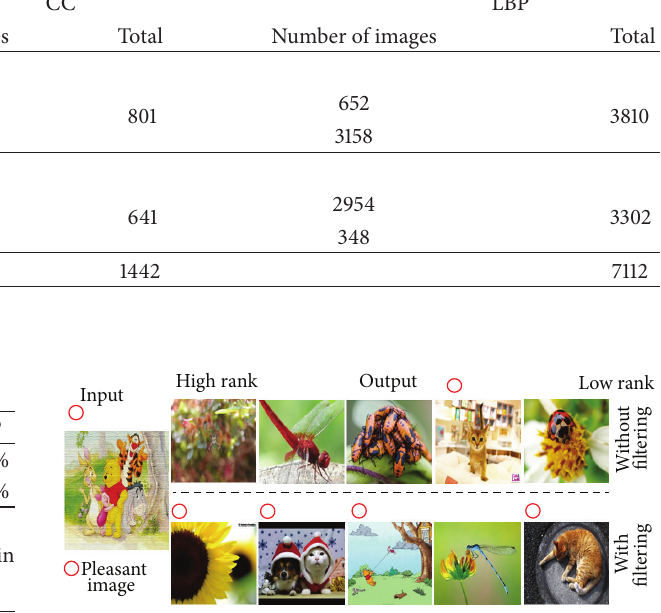
Figure 4: Improvement observed in the top-5 results (example 1).